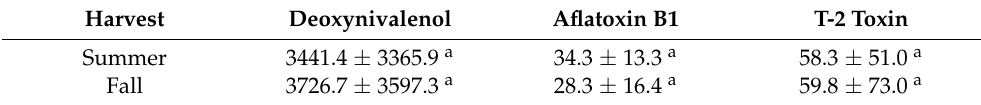
Table 5. Mycotoxin levels ( µ g/kg of dry matter) according to the harvest date. Deoxynivalenol Summer